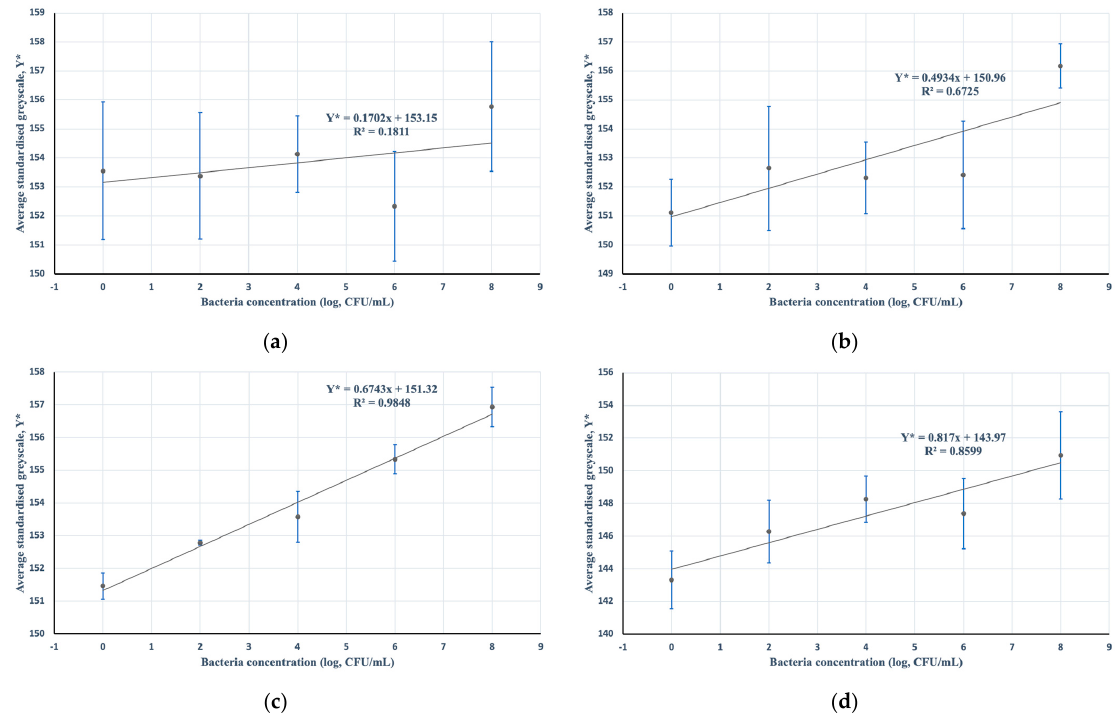
Figure 6. Data of the average standardized greyscale values of MTT-PMS strips against the log of bacteria concentration for different incubation periods ( n = 5): ( a ) 0 min; ( b ) 10 min; ( c ) 20 min; ( d ) 30 min.